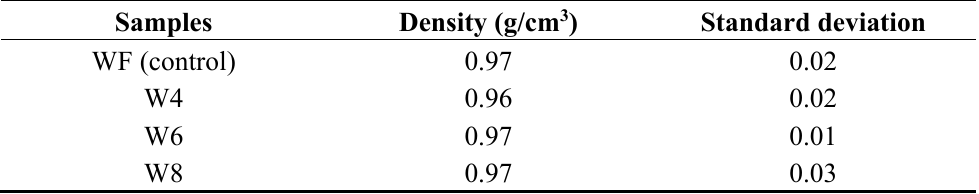
Table 3. Board densities are given as a function of pulverization